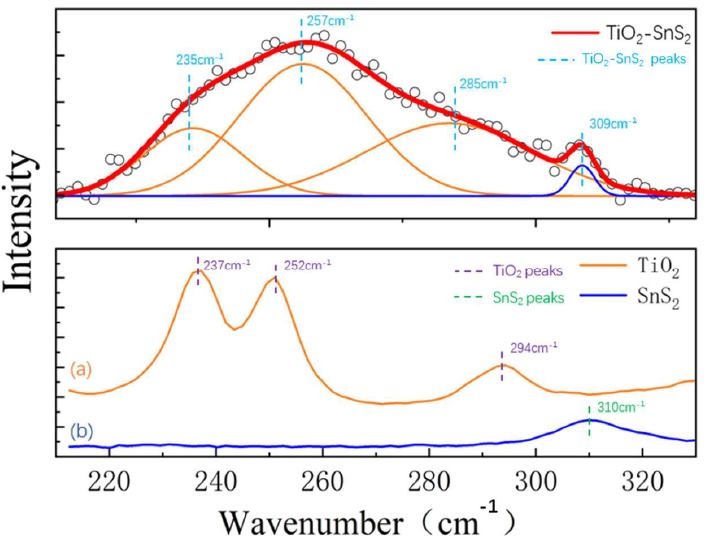
Figure 2. Raman spectrums of ( a ) the TiO 2 , ( b ) the SnS 2 and the TiO 2 -SnS 2 .